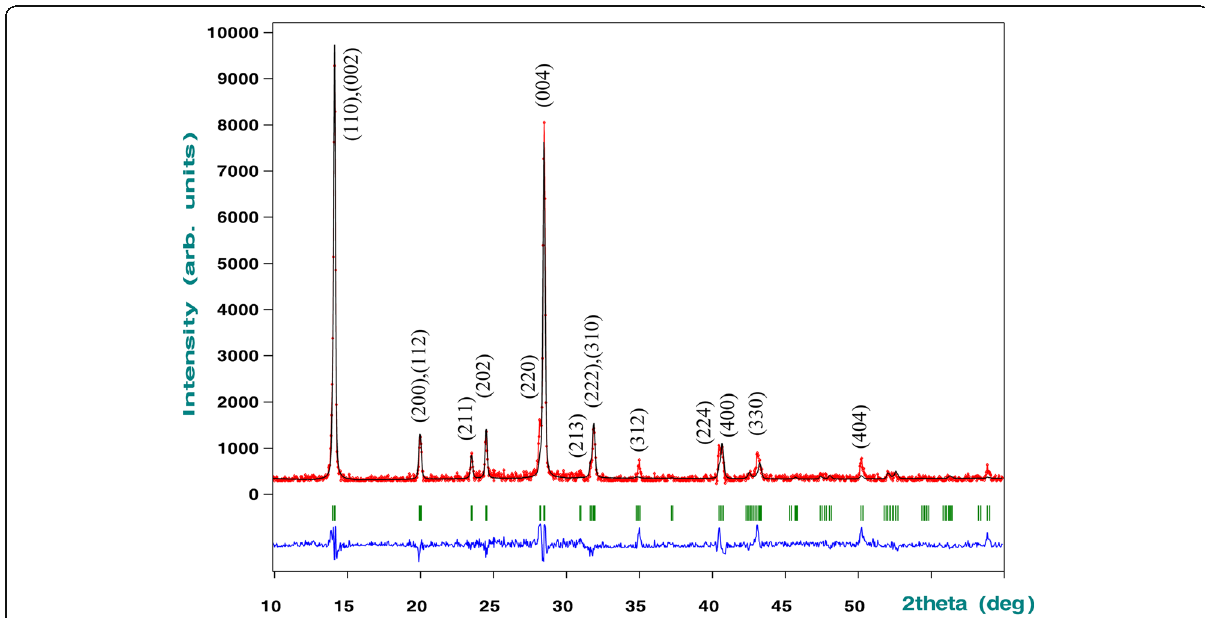
Fig. 1 Experimental (points) and calculated (lines) X-ray powder diffraction patterns of the CH 3 NH 3 PbI 2.98 Cl 0.02 films after heat treatment at 80 ° С and the ratio of starting reagents (PbI 2 and CH 3 NH 3 І ) 1:2. Vertical bands indicate the positions of the peaks; the Miller indices are in parentheses. The difference curve is shown